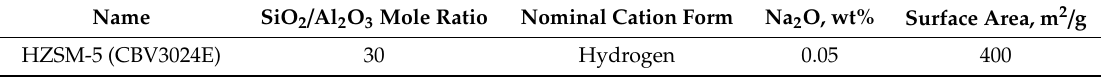
Table 2. Specifications of HZSM-5 Catalyst.